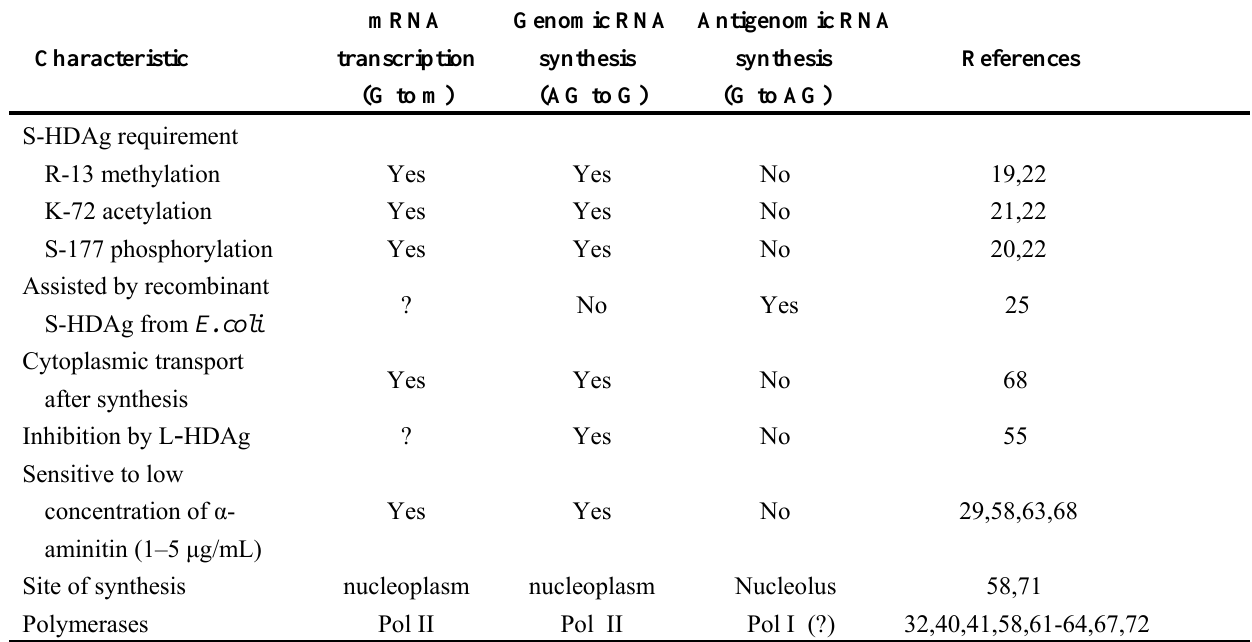
Table 1. Comparison of metabolic requirements for the synthesis of the various HDV RNA species a